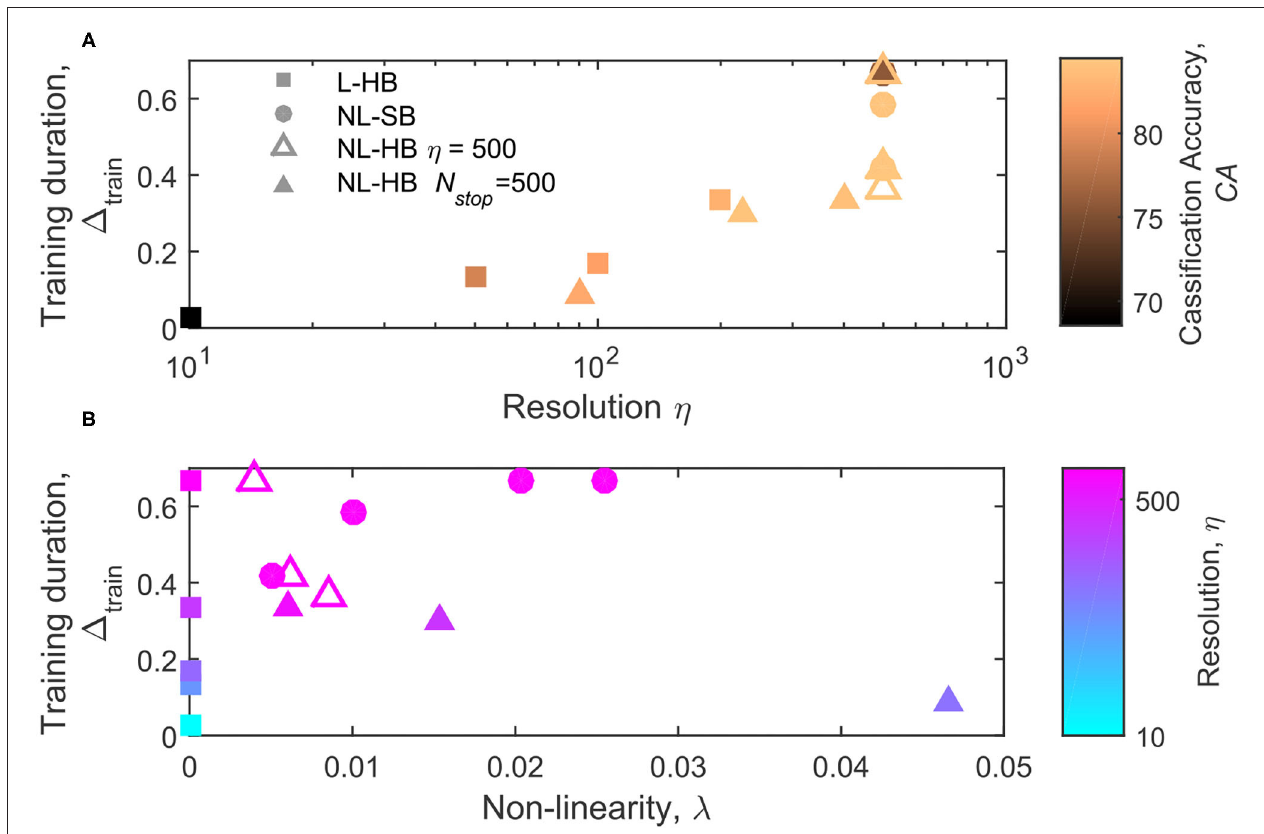
FIGURE 7 | Training duration, N train , as a function of the parameter η (A) and λ (B) , for the L-HB, NL-SB, and NL-HB cases. The symbols colors in follow the classification accuracy, CA, in (A) and the resolution value, η , in (B) according to the color bars reported on the right sides of the